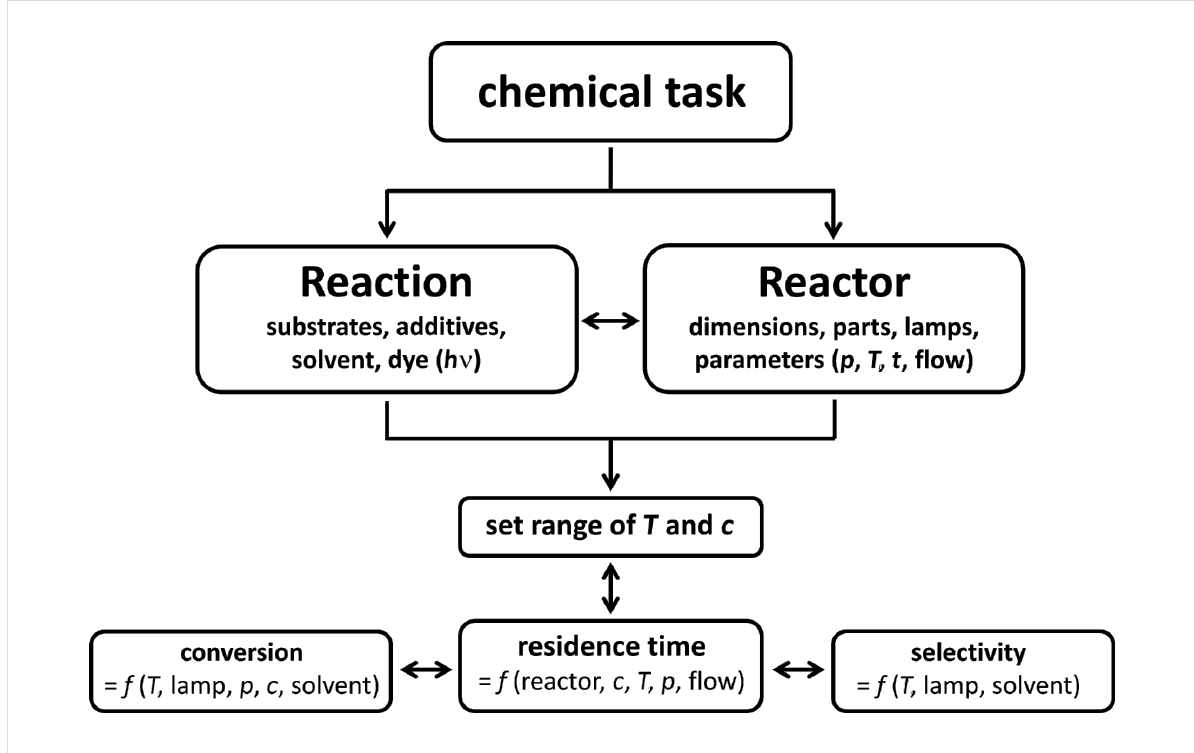
Scheme 1: Mutual interdependencies of critical reaction and reactor